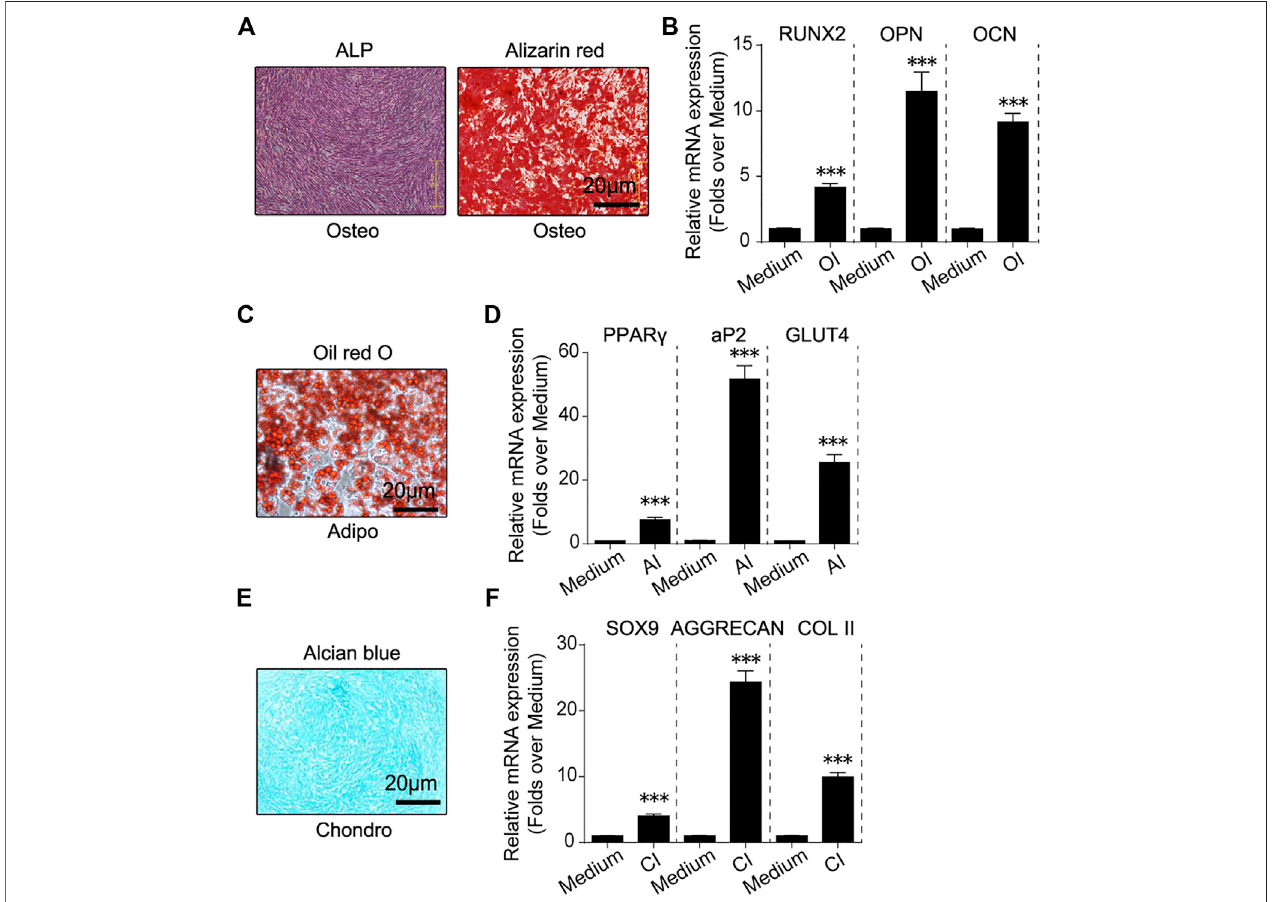
FIGURE 2 | In vitro osteogenic, adipogenic and chondrogenic differentiation of hHF-MSCs. (A) ALP and Alizarin red staining images of in vitro hHF-MSCs cultures when induced to undergo osteogenic differentiation. (B) mRNA expression of osteogenesis marker genes including Runx2, Opn and Ocn in in vitro hHF-MSCs cultures when induced to undergo osteogenic differentiation. OI: osteogenic induction. (C) Oil red O staining images of in vitro hHF-MSCs cultures when induced to undergo adipogenic differentiation. (D) mRNA expression of adipogenesis marker genes including PPAR γ , aP2 and Glut4 in in vitro hHF-MSCs cultures when induced to undergo adipogenic differentiation. AI: adipogenic induction. (E) Alcian blue staining images of in vitro hHF-MSCs cultures when induced to undergo chondrogenic differentiation. (F) mRNA expression of chondrogenesis marker genes including Sox9, Aggrecan and Col II in in vitro hHF-MSCs cultures when induced to undergo chondrogenic differentiation. CI: chondrogenic induction. GAPDH was used as internal control in RT-qPCR for osteogenesis and chondrogenesis. HPRT was used as internalcontrolinRT-qPCRforadipogenesis.Allthedatawereobtainedfromthreeindependentexperiments.Datawereshownasthemeans±s.e.m.*: p < 0.05,**: p < 0.01, ***: p < 0.001, NS: not signi fi